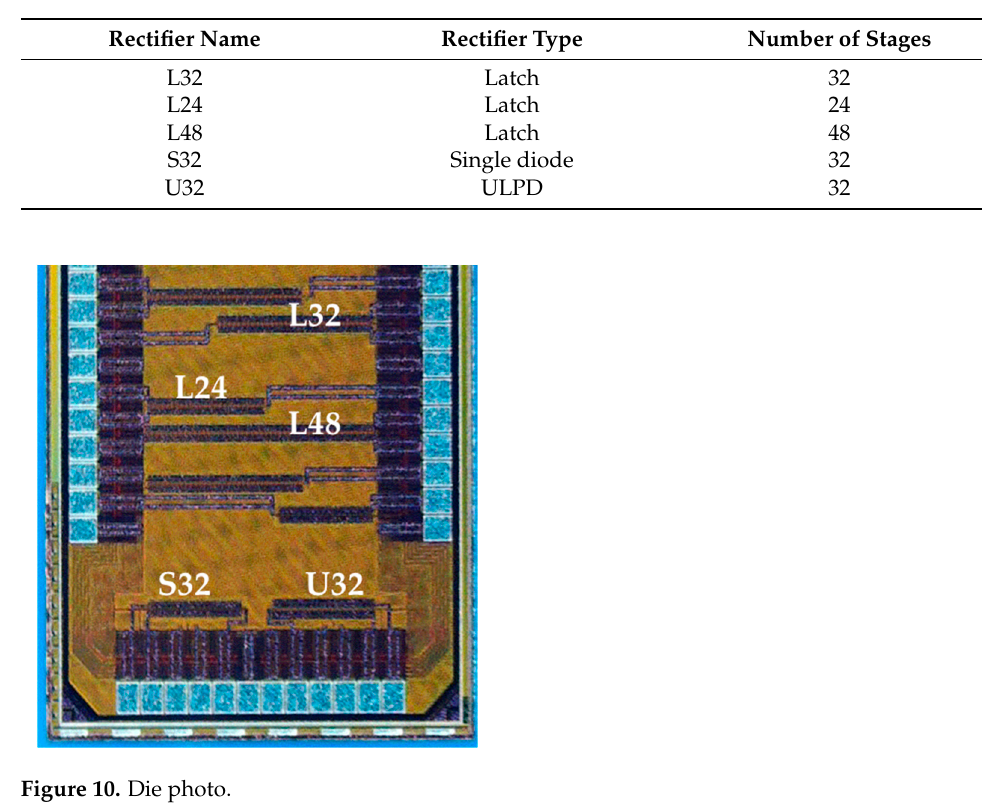
Figure 11. Block diagram of measurement setup ( a ) and its photo ( b ). The sensitivity was measured for each rectifier at a load resistance of 10 G Ω , as shown in Figure 12. Unlike SPICE results that showed that the sensitivity of latch rectifiers is the highest, measured results showed that of ULPD rectifiers is the highest.